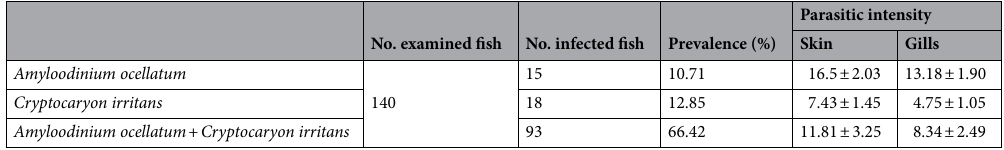
Table 1. Occurrence of protozoan infections in naturally infected Liza carinata . Prevalence % was calculated to according to the total number of examined fish. Examined fish were recorded as positive when 1 parasitic trophont was detected. The degree of protozoal intensity was done using protozoal count per examination field.